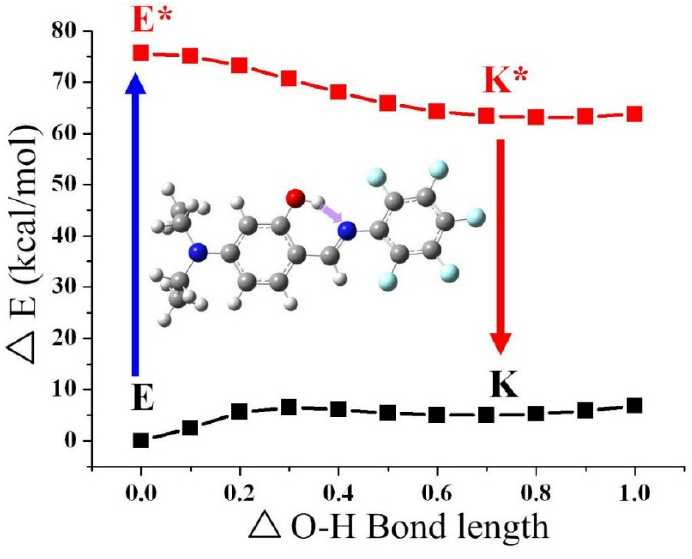
Figure 13. Potential energy curves from enol form to keto form of 4 at the ground state and excited state. The calculations are based on the optimized ground state geometry (S 0 state) at the B3LYP/6-31G